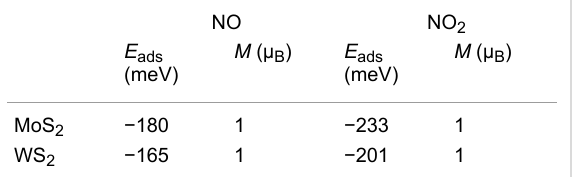
Table 1: Calculated values of adsorption energy ( E ads ) and magnetic moment ( M ) in equilibrium.